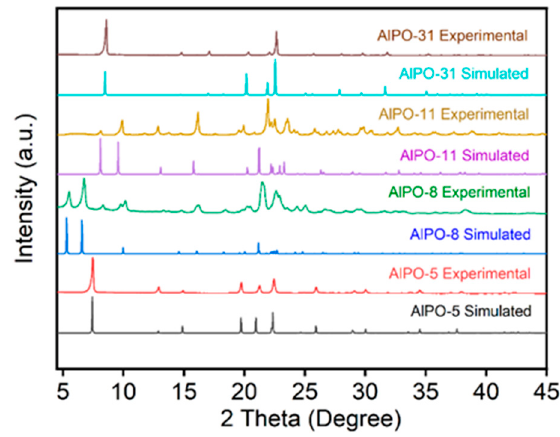
Figure 1. XRD patterns of synthesized AlPO-5, AlPO-8, AlPO-11 and AlPO-31. Table 1. Parameters of the structure of an elementary cell of aluminophosphate zeolites. Sample